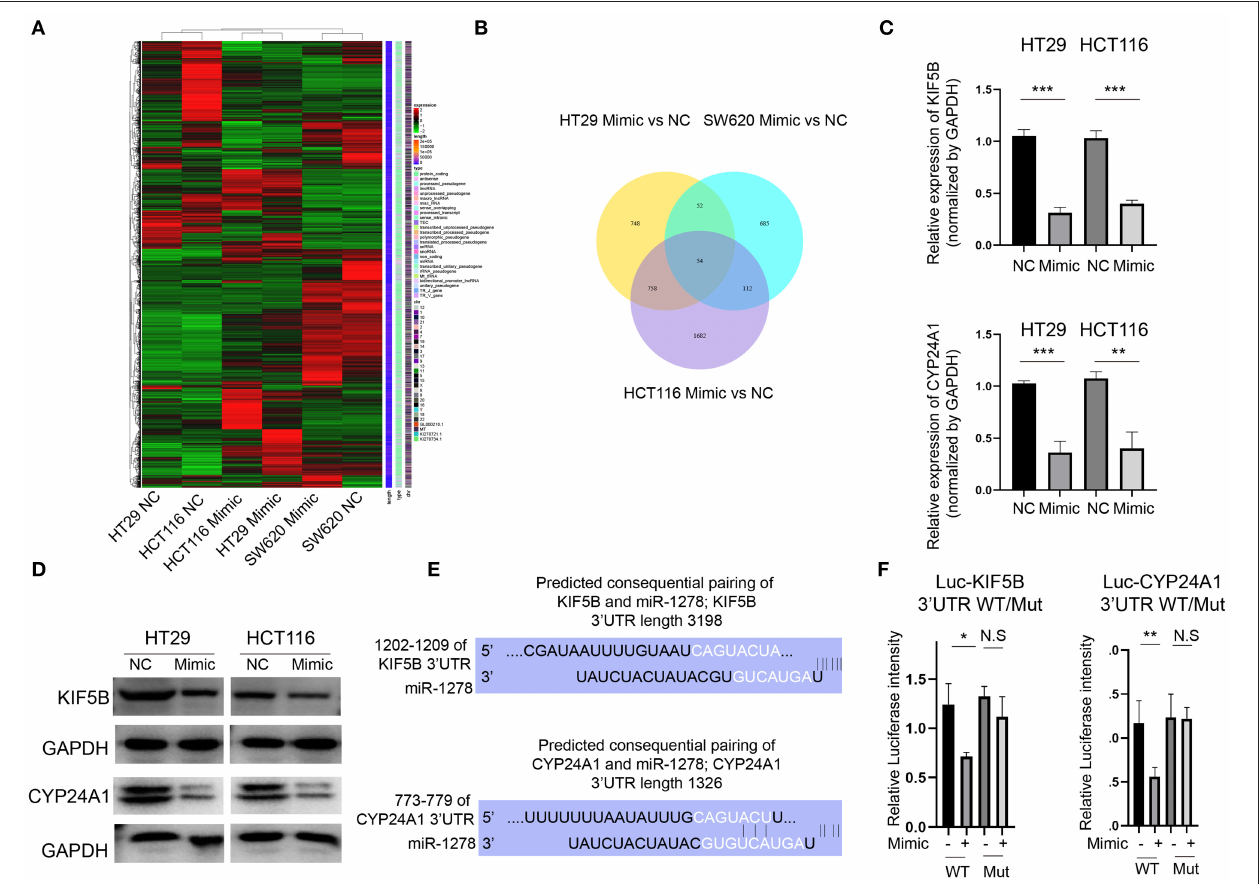
FIGURE 3 | KIF5B and CYP24A1 expression is inhibited by the miR-1278 mimic in CRC cells. (A) The miR-1278 mimic was transfected into three CRC cell lines (HT29, HCT116 and SW620), and RNA-seq was performed to compare whole gene expression variations between the mimic group and the control group. (B) In total, 1,612 genes, 2,606 genes, and 903 genes were screened at an absolute fold change value > 2 in HT29, HCT116 and SW620 cells, respectively. Only 54 genes consistently differed among the three cell lines. (C) Among them, two genes, KIF5B and CYP24A1, were selected for further analysis. The mRNA expression of KIF5B and CYP24A1 was verified by qRT-PCR in HT29 and HCT116 cells. (D) The protein expression of KIF5B and CYP24A1 was determined by Western blotting, indicating that the miR-1278 mimic markedly decreased the protein expression of KIF5B and CYP24A1 in HT29 and HCT116 cells. (E) The predicted consequential pairing of miR-1278 and the 3 ′ UTR of KIF5B or CYP24A1 was determined. (F) The luciferase reporter assay showed that miR-1278 directly binds with the KIF5B 3 ′ UTR and CYP24A1 3 ′ UTR. NC, negative control; Mimic, miR-1278 mimic; WT, wild type; Mut, mutated; * P < 0.05, ** P < 0.01, *** P < 0.001, N.S, no significance.